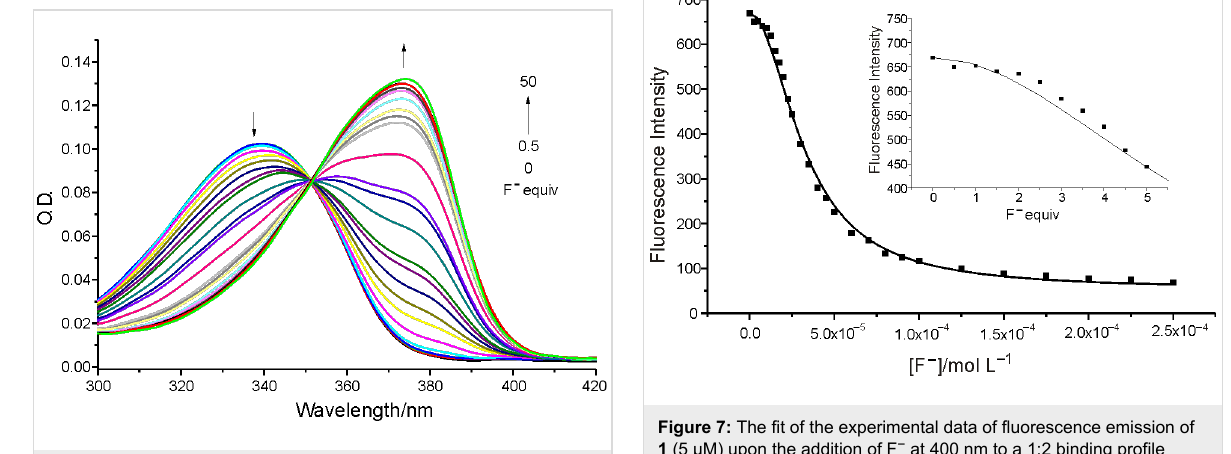
Figure 5: UV–vis absorption changes of 1 (5 μ M) upon the addition of TBAF in CH 3 CN.